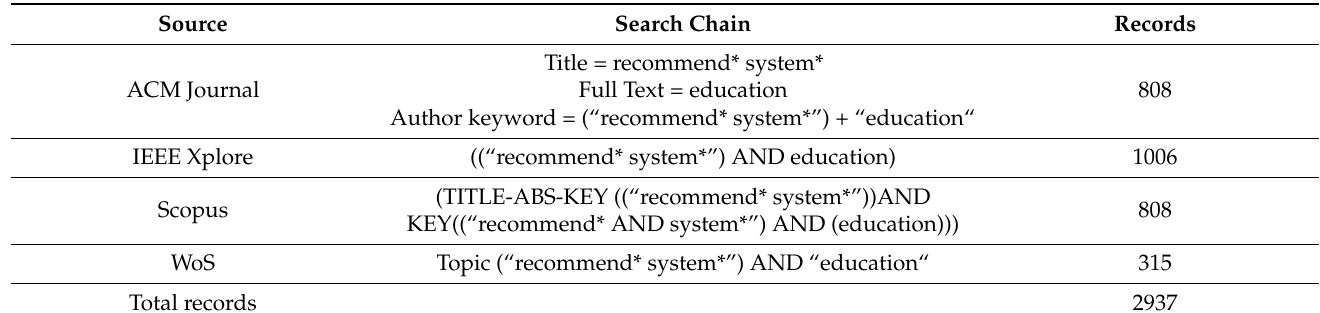
Table 2. Details of the